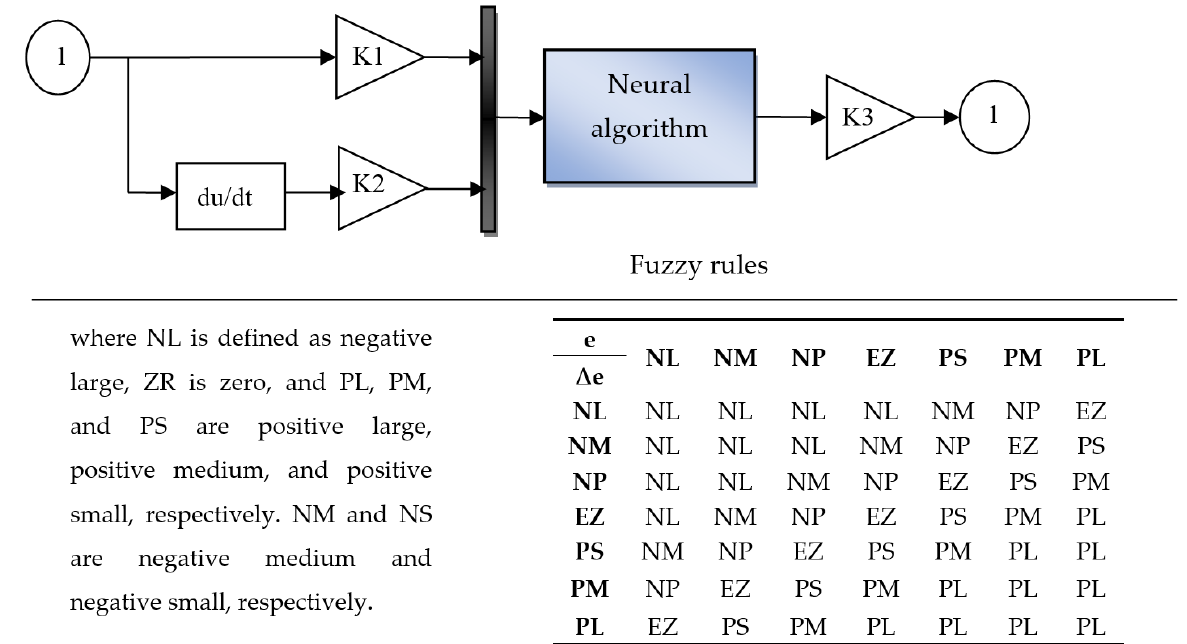
Figure 4. The internal structure of ANFIS algorithm.